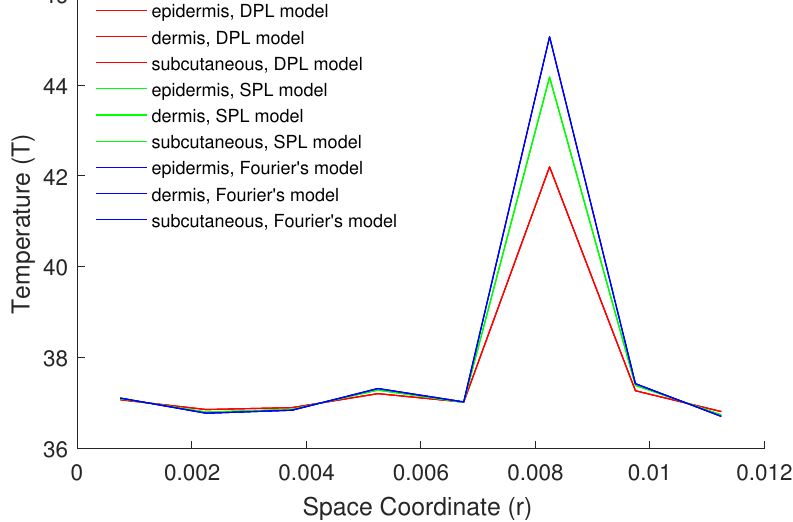
Figure 3. Comparison of three bioheat models in first kind